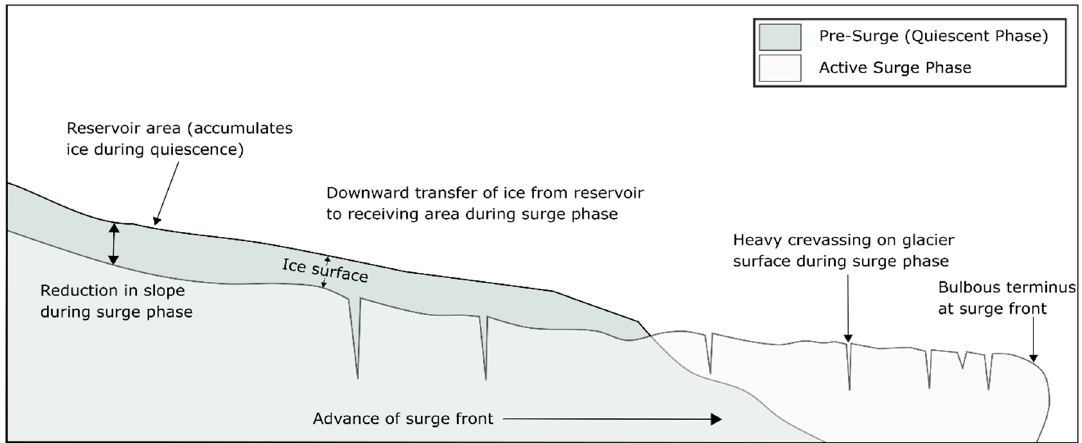
Figure 1. Schematic diagram showing generalised glacier response pre-surge (quiescent phase) and during an active surge phase.